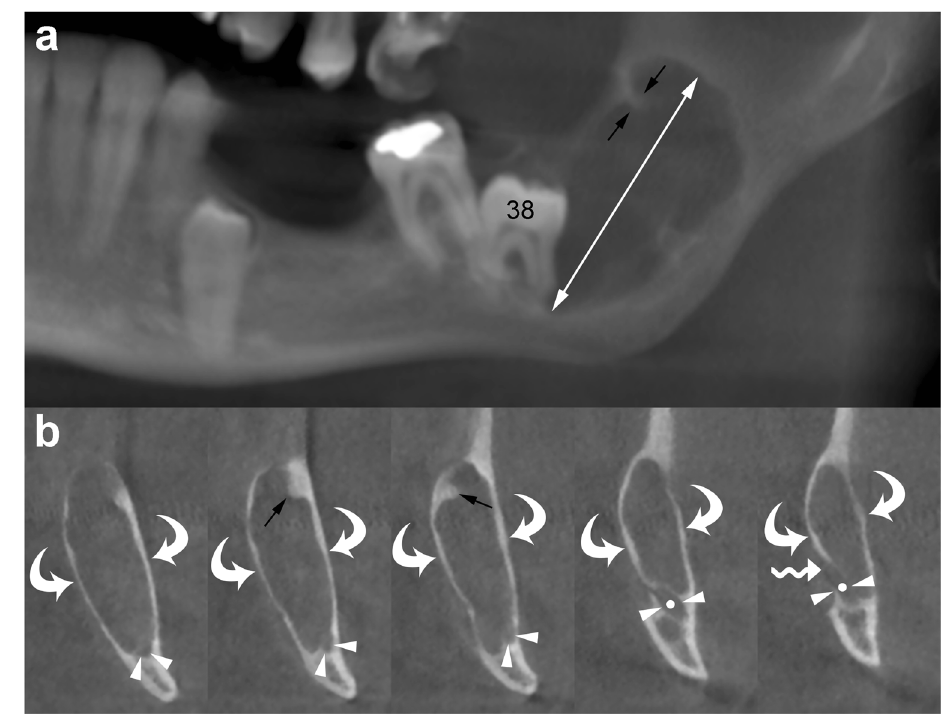
Fig. 7 Panoramic CBCT image with 20-mm slice thickness ( a ) shows a mandibular OKC with a septum ( opposing arrows ) which seems to divide the lesion into two large loculations. Note the displacement of adjacent teeth. Panoramic ( b ) and axial ( c ) CBCT images reconstructed as 0.5- and 0.2-mm-thick sections demonstrate that the septum is incomplete ( arrows ). Perforation of the buccal cortex in the anterior portion of the lesion is also shown ( curved arrows